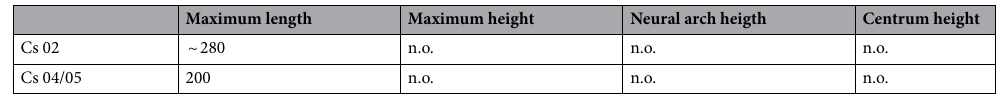
Maximum length Maximum height Neural arch heigth Centrum height Cs 02 ~ 280 n.o. n.o. n.o. Cs 04/05 200 n.o. n.o. Table 3. Selected measurements of sacral vertebrae (IVPP V27875) (in mm). n.o., not observable.